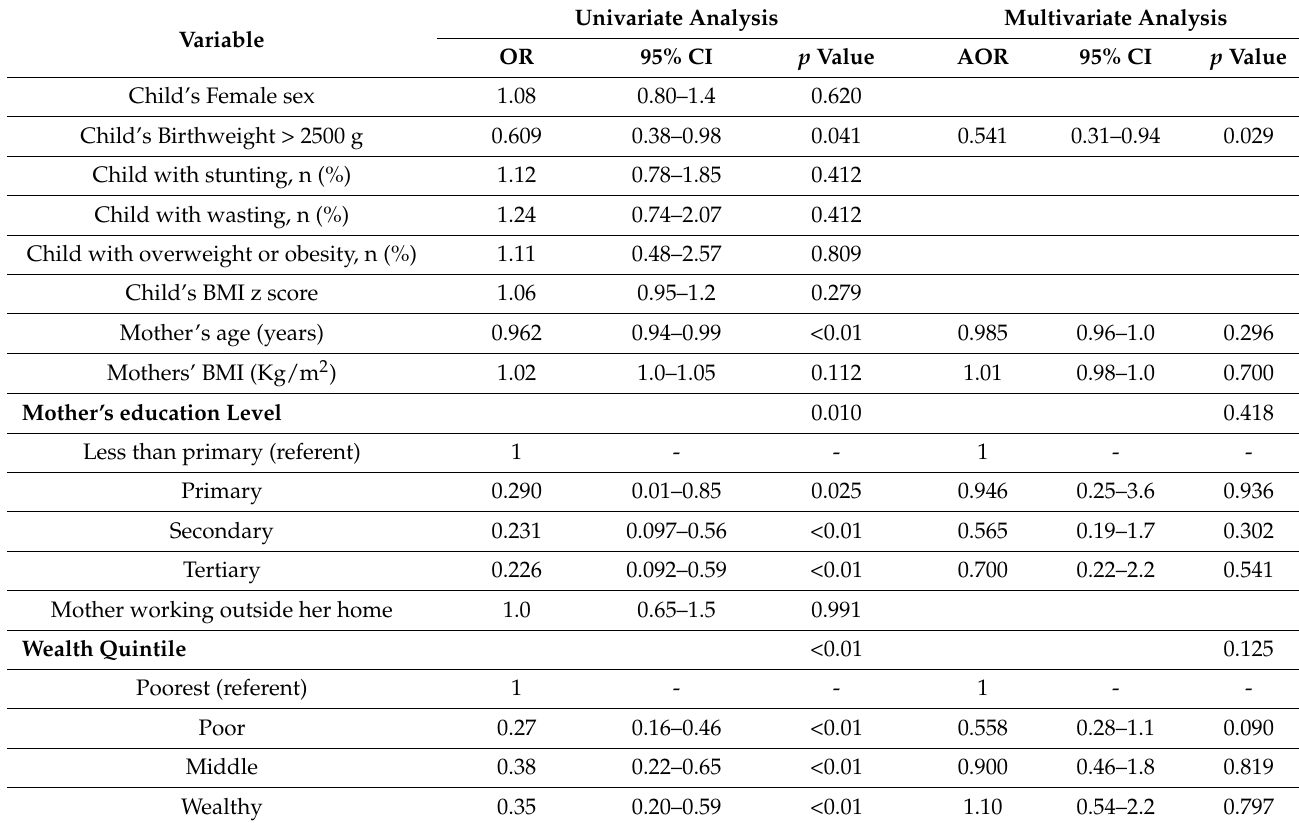
Table 4. Logistic Regression of acceptable diet by selected